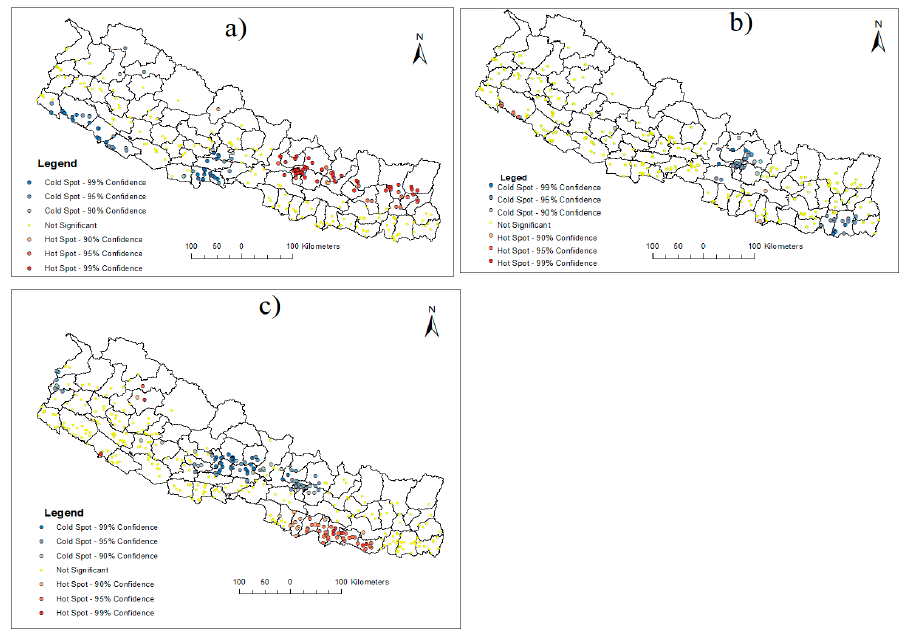
Figure 2. Spatial distribution of hotspots and coldspots of anemia among under-five children in Nepal, 2006 ( a ), 2011 ( b ), and 2016 ( c ). (Note: “Anemia was measured using a hemo-cue device which has gone through technical changes over the years to improve measurement precision, thus limiting the data comparability over the years”.)